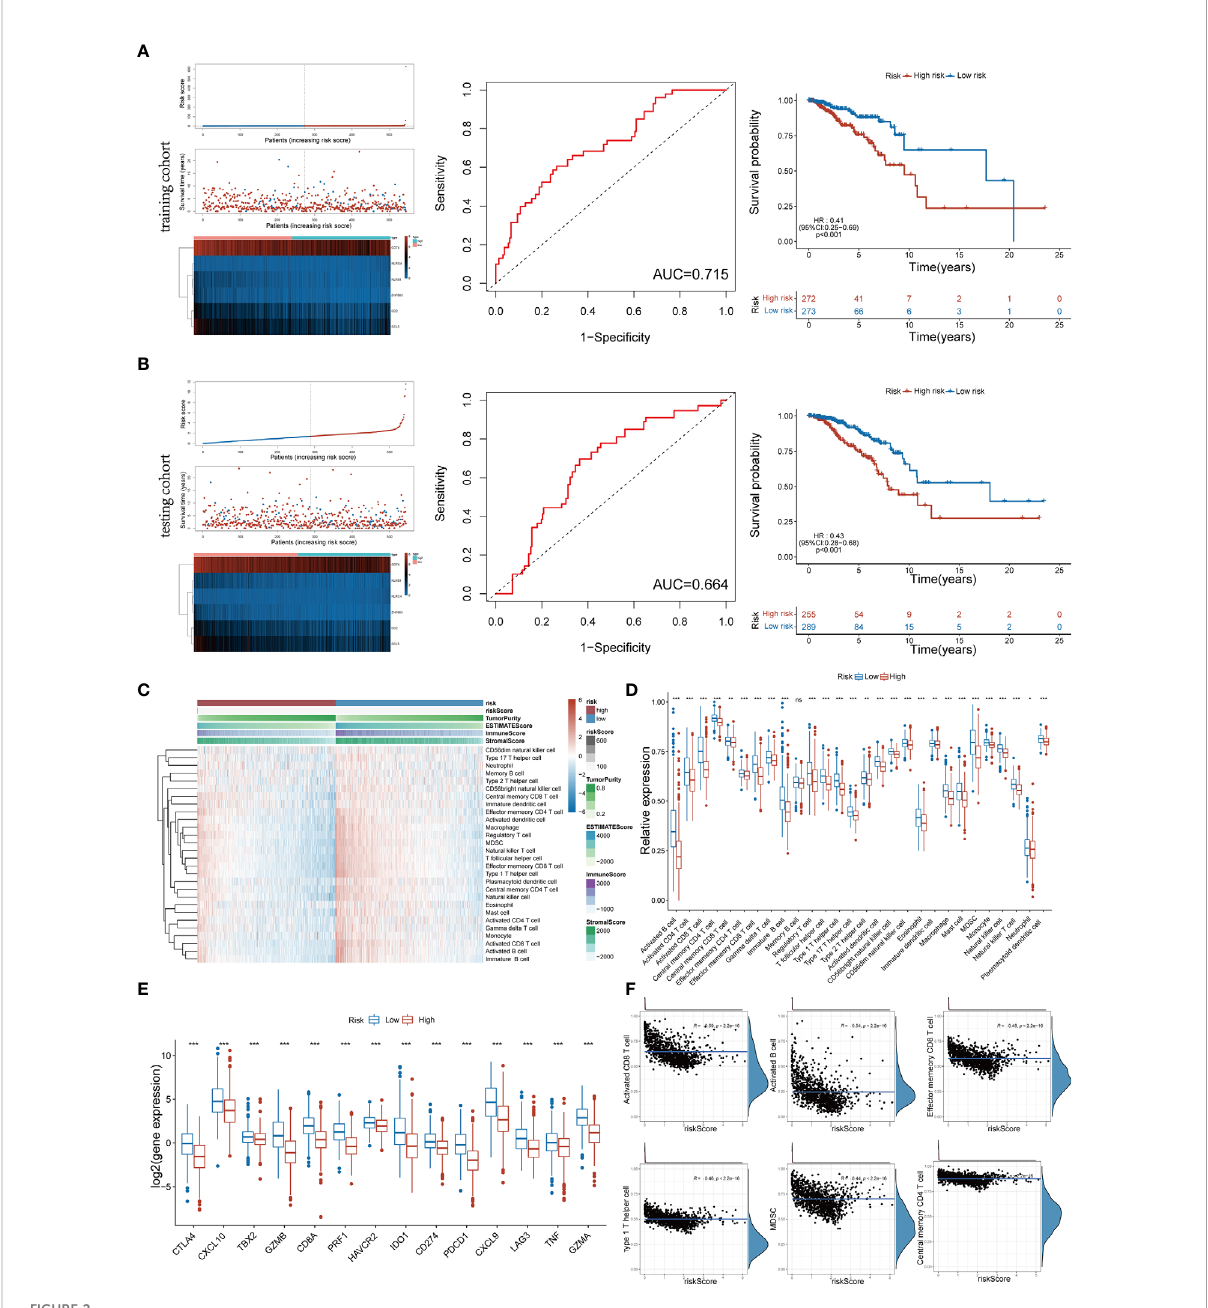
FIGURE 2 Distribution of risk scores and survival status, heatmap of six Pyro-GPS, and Kaplan – Meier curves of OS for BRCA patients in TCGA training cohort (A) and testing cohort (B) . (C) Heatmap of correlations between risk scores with ImmuneScore, StromalScore, ESTIMATEScore, Tumor Purity and 28 immune cell types. (D) The in fi ltration levels of 28 immune cell types in high-/low-risk subtypes. *p < 0.05, **p < 0.01 and ***p < 0.001. (E) The expression levels of 14 immune-oncology targets in high-/low-risk subtypes. (F) The relevance between in fi ltration of activated CD8 T cell, activated B cell, effector memory CD8 T cell, type 1 T helper cell, MDSC and central memory CD4 T cell with risk score. Pyro-GPS, pyroptosis-related genes prognostic signatures; OS, overall survival; BRCA, breast cancer; TCGA, The Cancer Genome Atlas. ns, no signi fi